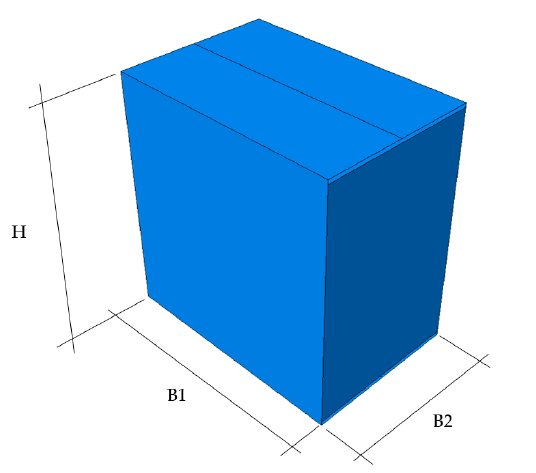
Figure 7. Box dimension symbols.